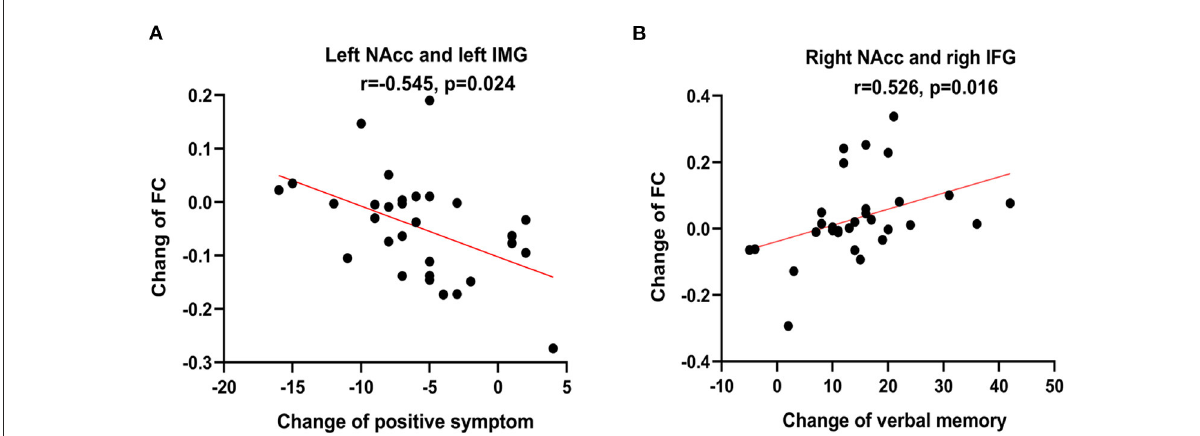
FIGURE5 Correlations analysis showed that the changed functional connectivity (FC) value of left nucleus accumbens (NAcc) with the left inferior temporal gyrus (IMG) is negatively correlated with the change of positive symptom score of PNASS ( r = − 0.545, p = 0.024, False discovery rate correction) (A) and FC value of the right NAcc with the right inferior frontal gyrus (IFG) is positively correlated with the change of verbal memory score ( r = 0.526, p = 0.016, False discovery rate correction) (B)